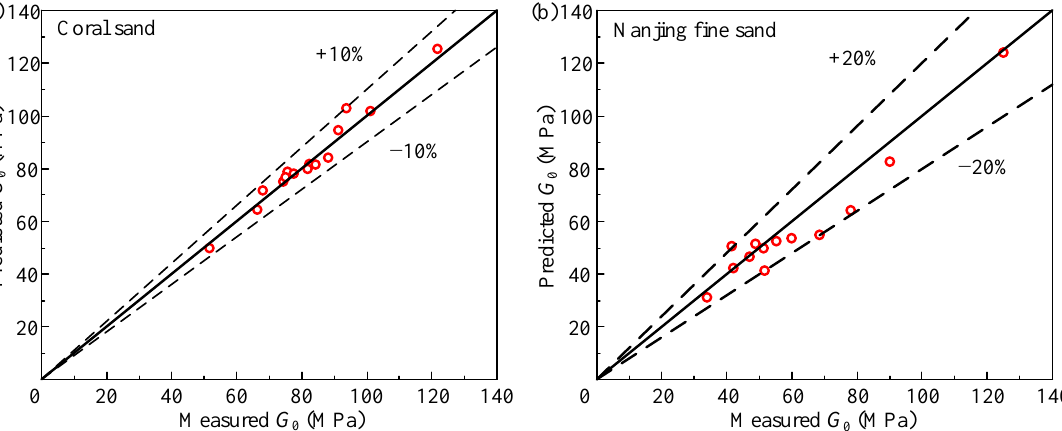
Figure 9. The comparison between the experimental G 0 versus predicted G 0 of ( a ) coral sand and ( b )